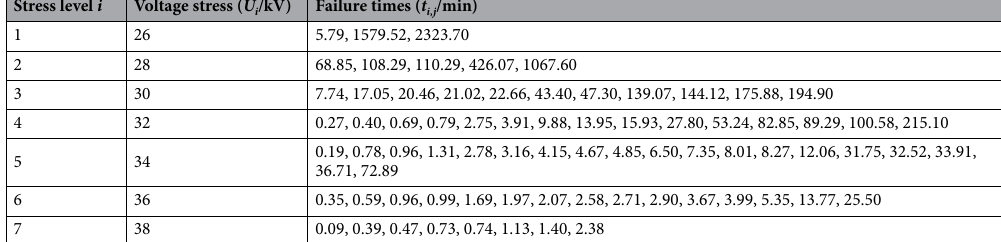
Table 1. Constant ALT data for a transformer insulating oil with different